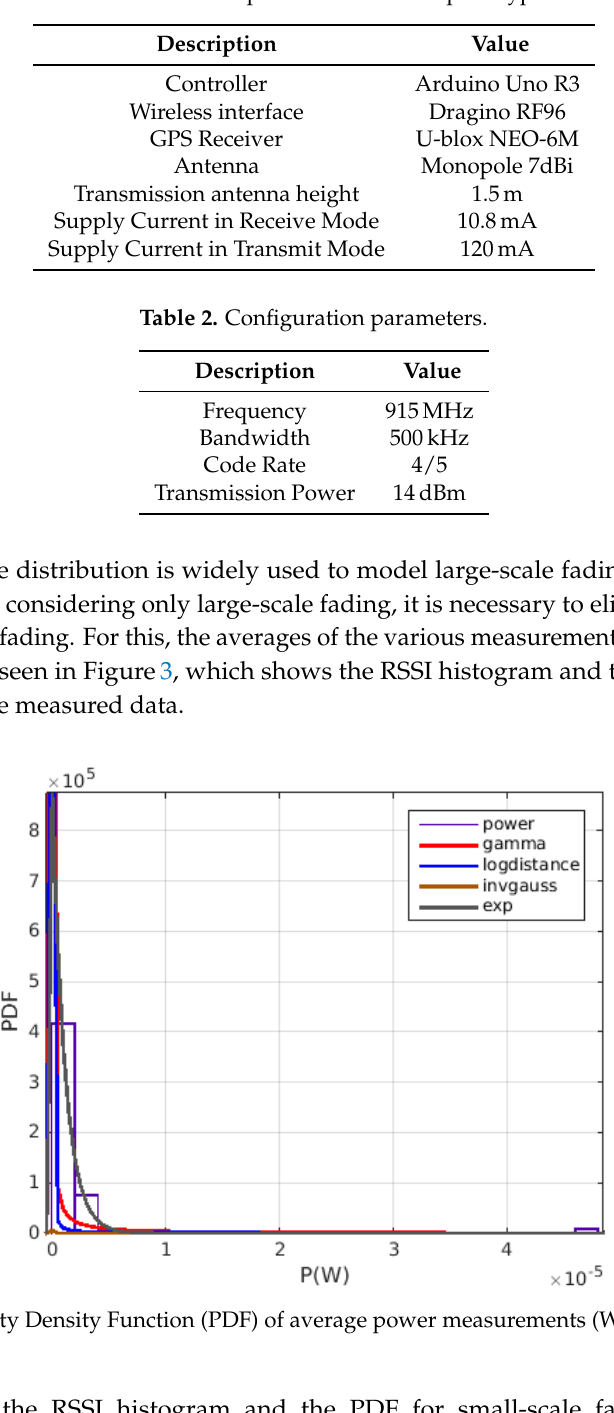
Table 1. Hardware components used in the prototype nodes.